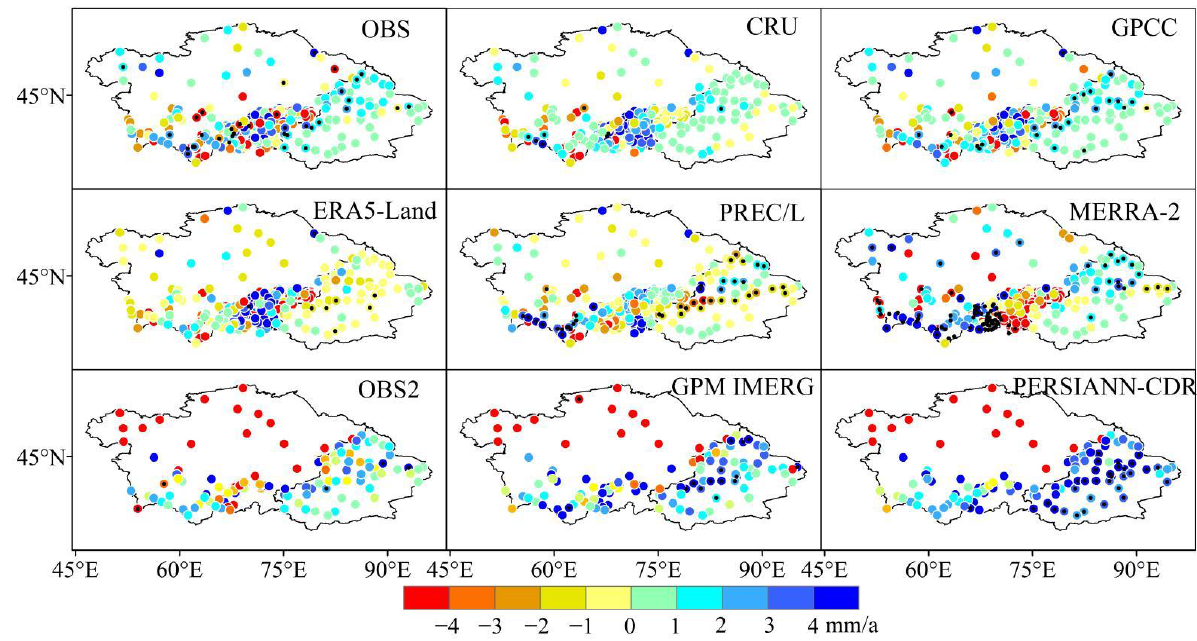
Figure 6. Spatial distribution of the annual precipitation trend (mm/a) for OBS, OBS2, and seven gridded products in ACA (the black dots indicate the trends passing the 95% confidence level test).